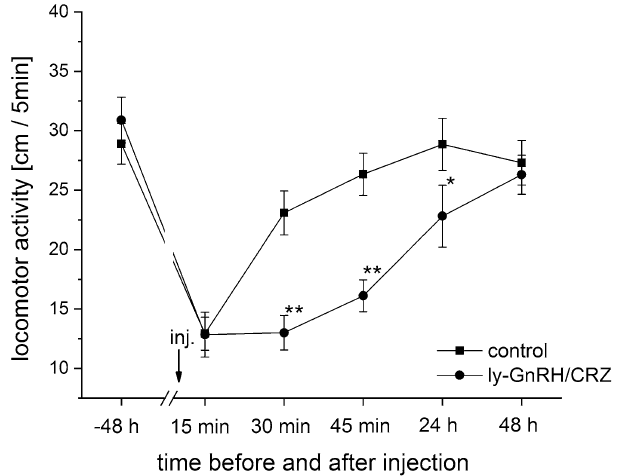
Figure 3. Locomotor activity (distances covered by snails/5 min) of experimental groups. Each data point represents mean ± SEM (n = 10 animals/group/replicates). Within a single time point, significance of differences to the control is indicated by asterisks (* P < 0.05 and ** P < 0.01).